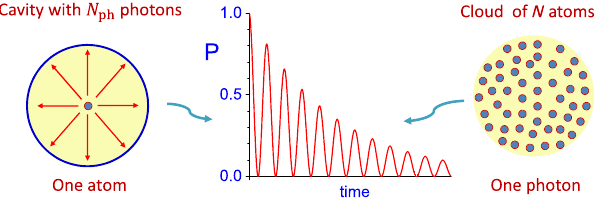
FIG. 1. For a very large cloud, the photon is reabsorbed and reemitted many times, and the atomic state oscillates with a ffiffiffiffi p N frequency that goes as . This behavior is to be compared to the cavity QED scenario in which an atom is cycled between the ground and excited states with a frequency that goes as where N ph is the number of photons in the cavity. P is the probability that an atom is